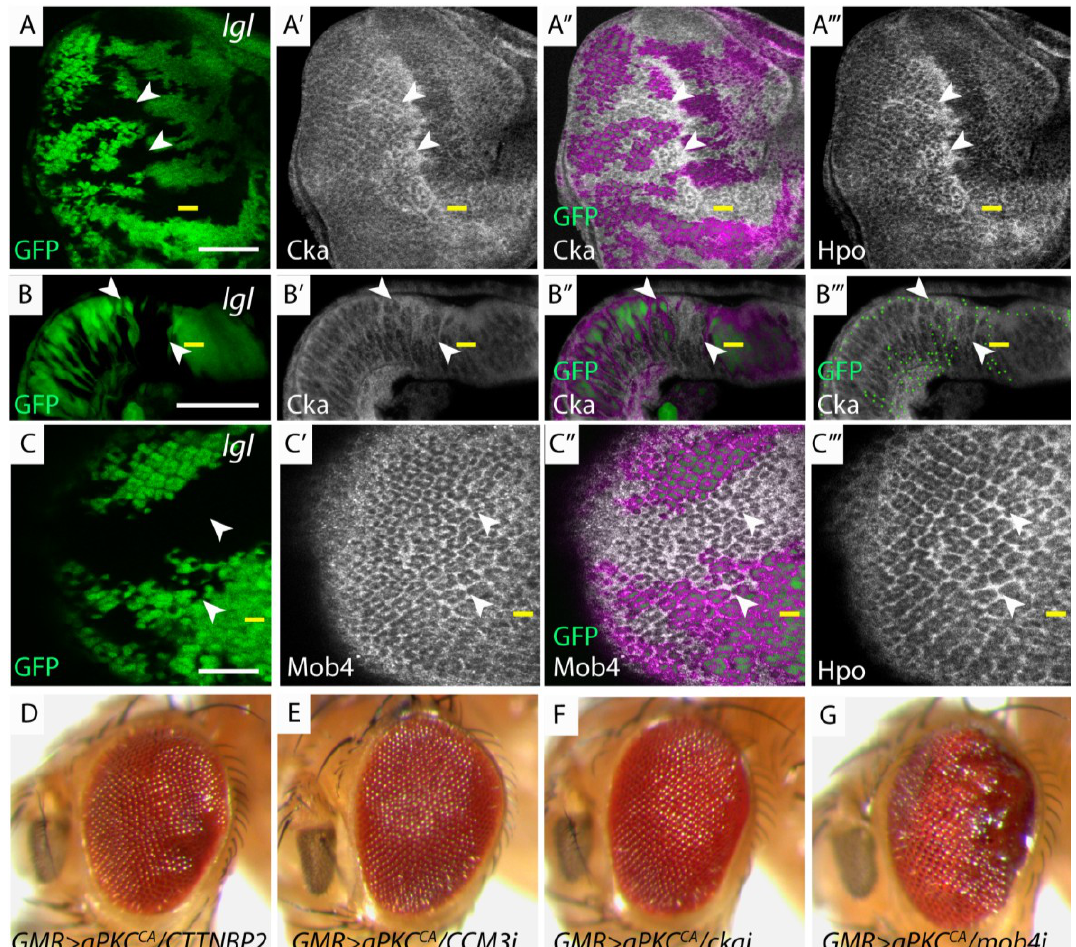
Figure 3. Members of the dSTRIPAK complex are mislocalized in lgl −/− tissue and genetically interact with GMR>aPKC CA . ( A , C , H , I ) Planar sections of larval eye discs; ( B ) Cross section of larval eye disc. Yellow line indicates morphogenetic furrow. White scale bar represents 50 µM; ( A , A' , A''' ) lgl −/− mosaic eye disc stained for Cka (white) and Hpo (white) respectively. Mutant clones display apical accumulation of Hpo and Cka (arrowheads); ( B , B' ) lgl −/− mosaic eye disc, stained for Cka (white) displays apical accumulation and basolateral mislocalization of Cka (mutant tissue GFP negative, white arrowheads indicate Cka mislocalization); ( B''' ) Green dots outline GFP clone boundaries; ( C , C' , C''' ) lgl −/− mosaic eye disc, stained for Mob4 (white) and Hpo (white) respectively. Only moderate accumulation of Mob4 was observed compared to Hpo (mutant tissue GFP negative, arrowheads indicate Mob4 mislocalization); ( A" – C" ) Overlay of GFP and antibody staining, pink highlights wildtype GFP positive tissue; ( D – G ) Adult female eye images of GMR > aPKC CA and depletion of dSTRIPAK components; ( D ) CTTNBP2 ; ( E ) CCM3i ; ( F ) ckai ; ( G ) mob4. Reducing the levels of mob4 , but not other dSTRIPAK components, in conjunction with GMR > aPKC CA alters tissue growth.